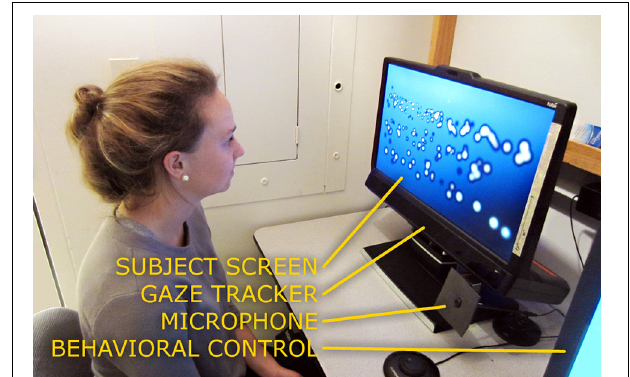
FIGURE 1 | System architecture. The system consists of the Tobii TX300 gaze tracker operating in normal, streaming mode. Gaze position information relative to the TX300’s built-in display screen is streamed over a low-latency dedicated connection to an intermediary interface computer that runs a small gaze-position server program. The server code accepts streaming data and, upon request from the behavioral control system, computes an instantaneous gaze position value (with non-linear noise reduction), that is returned over a second, low-latency dedicated connection. The behavioral computer runs the experiment and performs data logging. Whenever the behavioral task requires instantaneous gaze information (such as during the Reading Phase of the task; see main text), a request is sent to the gaze-position server that typically replies in under 2ms. Total system latency from gaze measurement to video frame update is typically under 16ms, with an additional 4ms of LCD lag to an updated image on the subject retina. The intermediary gaze-position server eliminates the need for the behavioral control system to deal with streaming data, and thus simplifies the overall design, at the cost of a modest increase in total system latency.